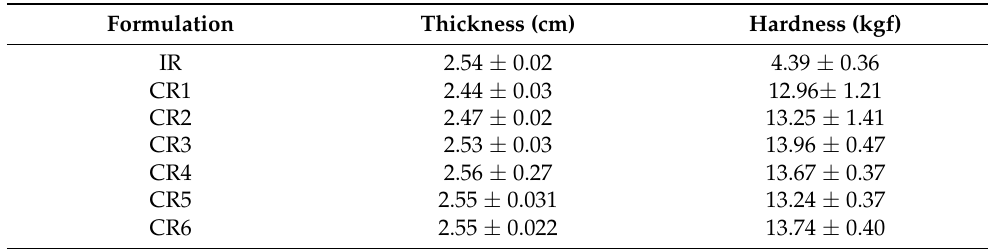
Table 2. Physical properties of tablets for the immediate release and controlled-release formulations (CR1–CR6) ( n = 10) ± standard deviation.